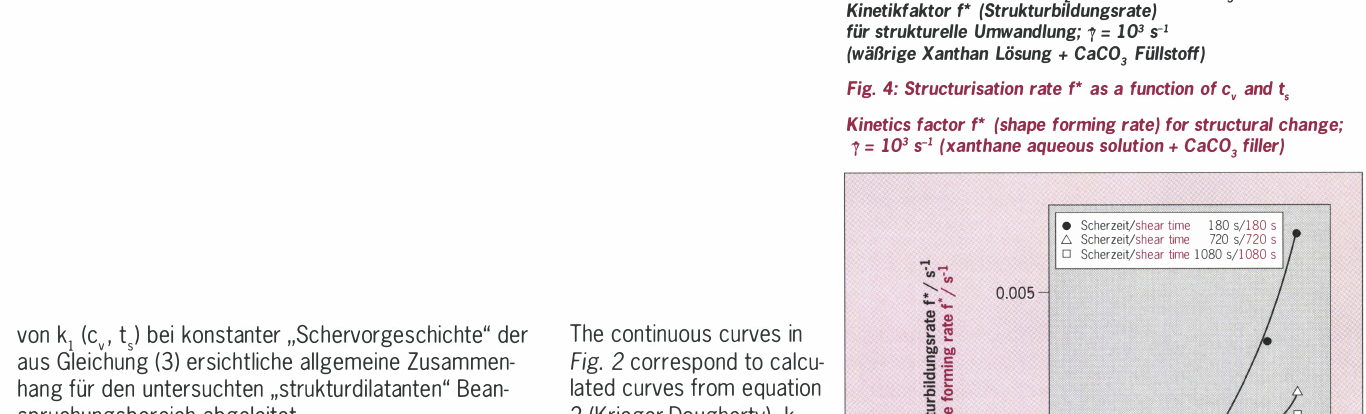
Fig. 4: Structurisation rate f* as a function of c, and t, Kinetics factor f* (shape forming rate} for structural change; 1()3 s-1 (xanthane aqueous solution 1 =